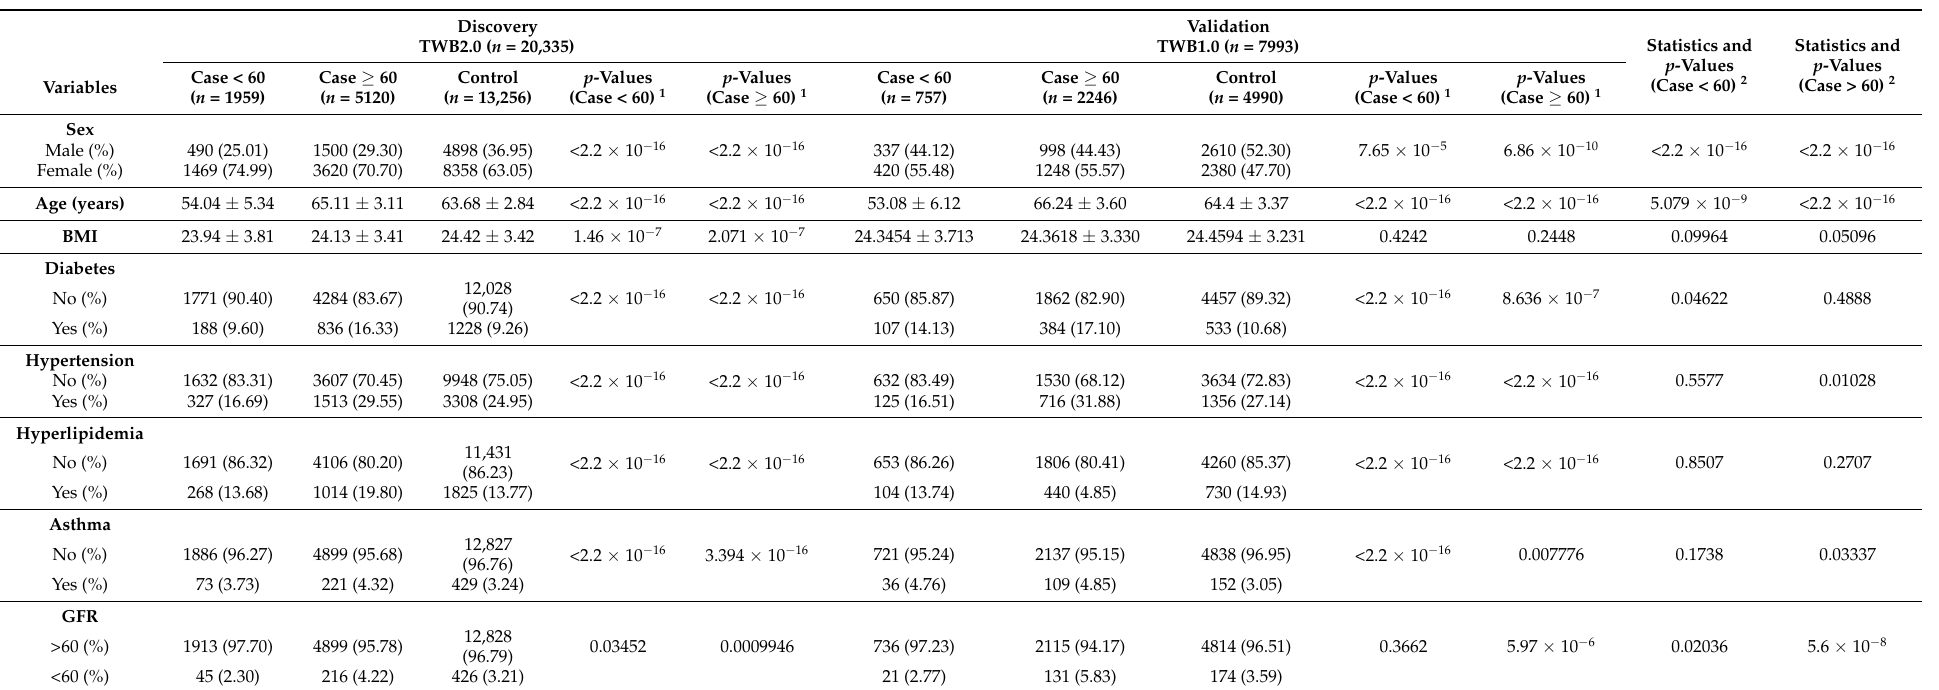
Table 1. Participant characteristics from TWB 2.0 and TWB